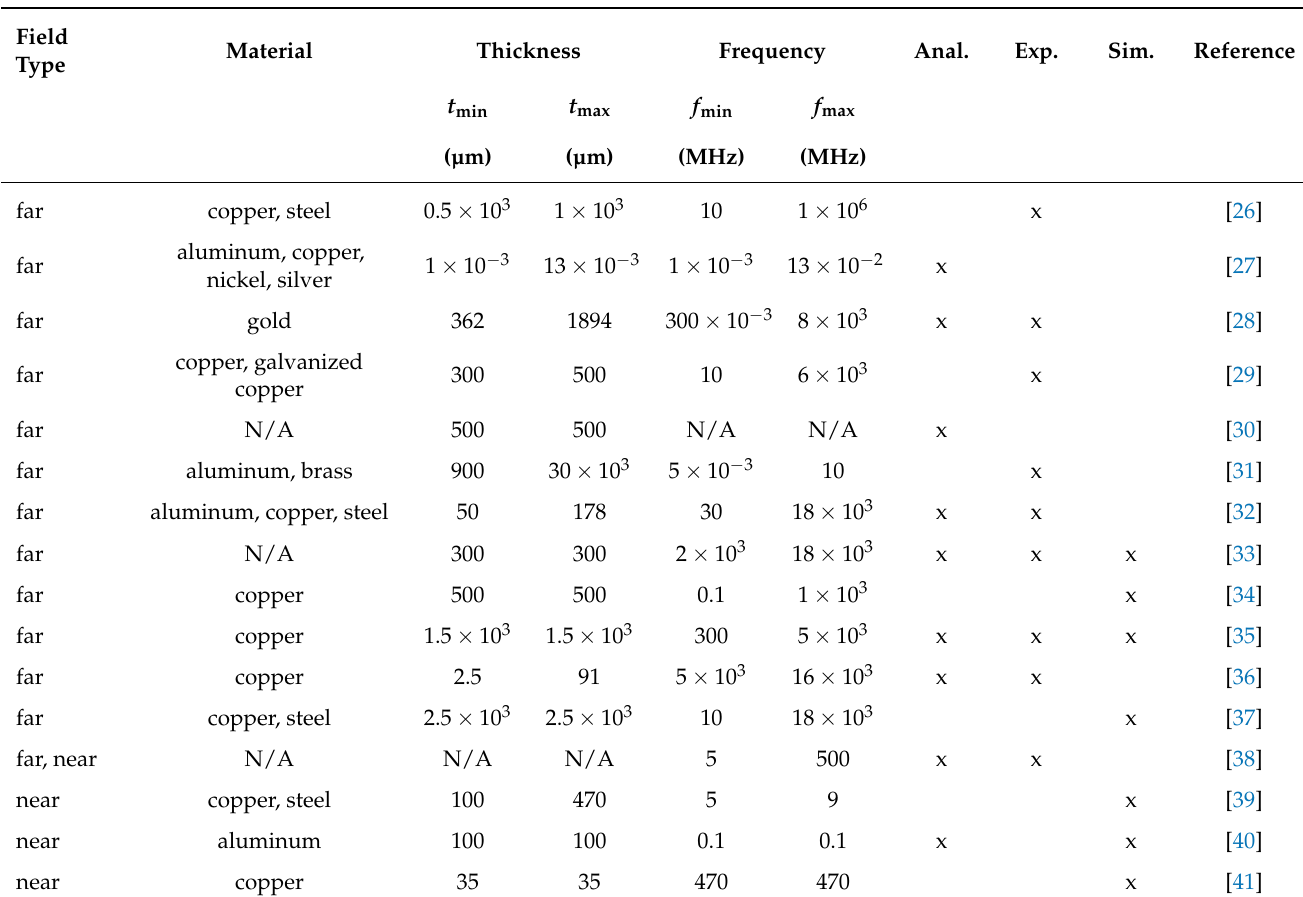
Table 1. Overview of existing research on the shielding effectiveness of metal wire